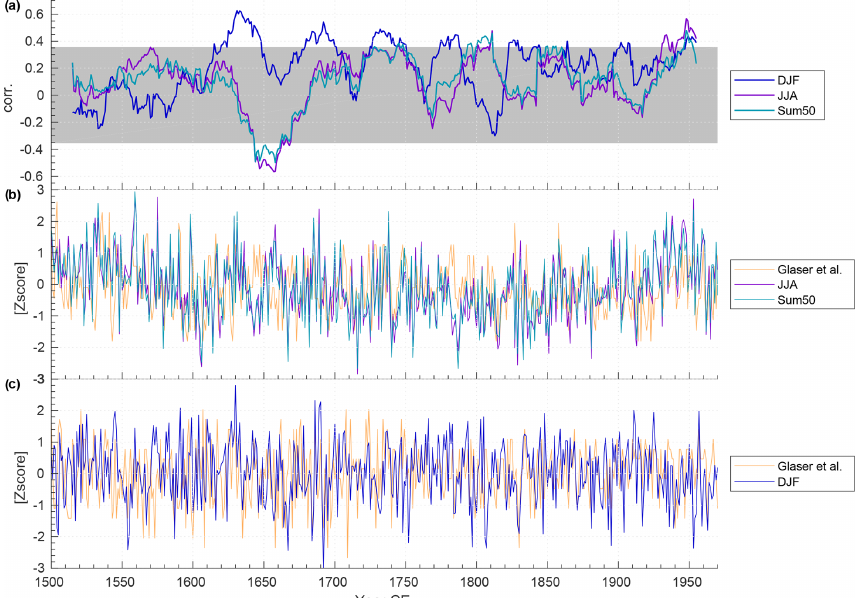
Figure 14. (a) Moving 31-year correlation between the Glaser and Riemann (2009) central Europe temperature index (JJA, DJF) and reconstructed temperature from this study (JJA, sum50, DJF). Correlations beyond the gray shaded area are significant ( p < 0 . 05). (b) Time series of the Glaser and Riemann (2009) central Europe temperature index (JJA) and reconstructed temperature from this study for summer (JJA, sum50). (c) Time series of the Glaser and Riemann (2009) central Europe temperature index (DJF) and reconstructed temperature from this study (DJF). For the reconstructed temperature from this study we extract the area mean temperature (T2m) for the box 50–60 ◦ N and 0–20 ◦ E using only values for